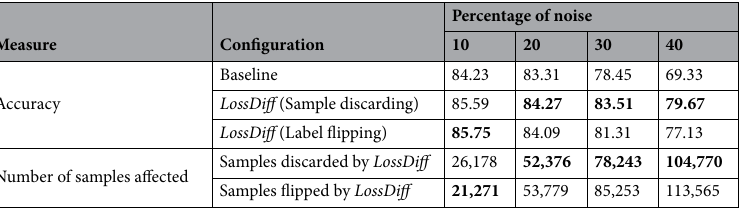
Table 8. Accuracy comparisons for different noise levels between the baseline method (with label noise) and LossDiff (without label noise) for sample discarding and label flipping approaches. Significant values are in bold.